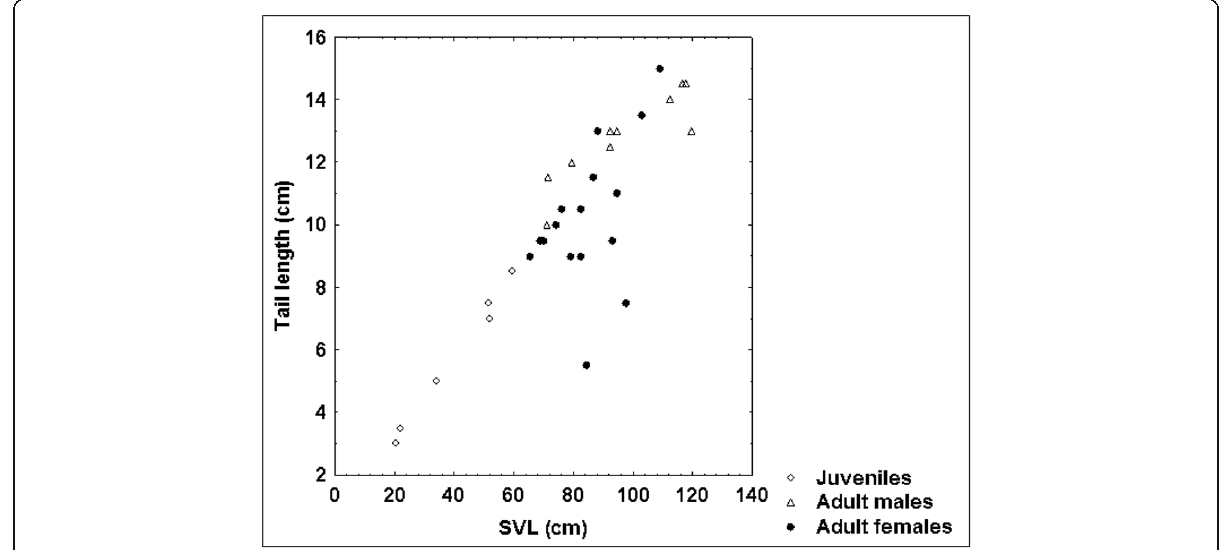
Fig. 9 Relationship between SVL and TaL in 34 blunt-nosed vipers from Cyprus: R =